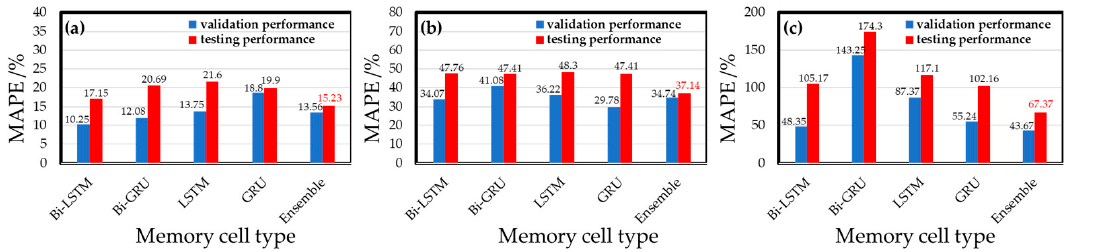
Figure 14. Performance differences between single gas model and ensemble gas model of ( a ) CO gas model, ( b ) O 3 gas model, and ( c ) NO 2 gas model.